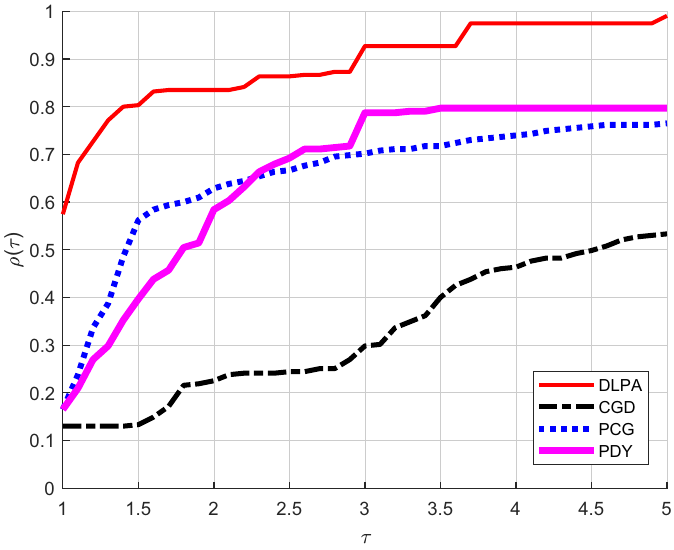
Figure 2: Performance pro fi le of DLPA, CGD, PCG, and PDY methods in terms of number of function evaluations.